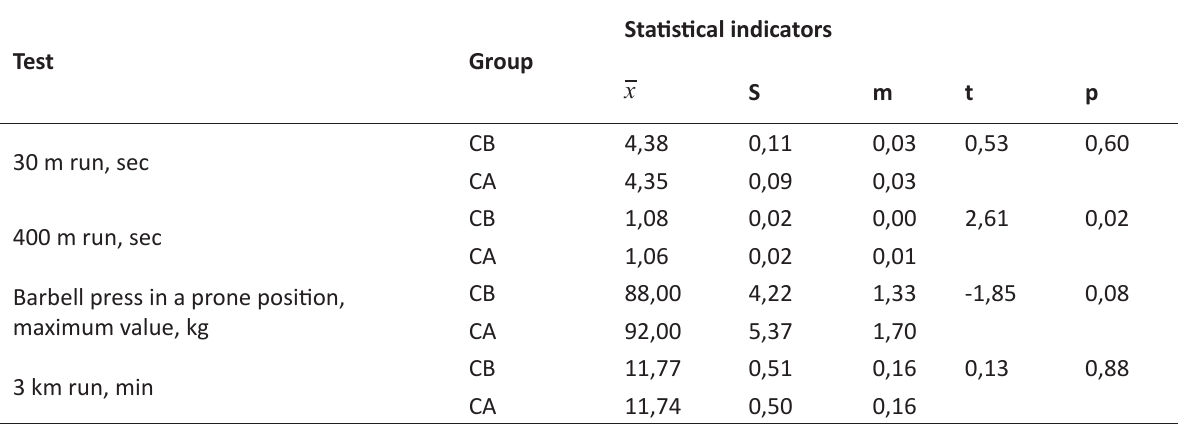
Table 3. The indicators of physical fitness of young rugby players of the control group before and after the experiment (n = 10)